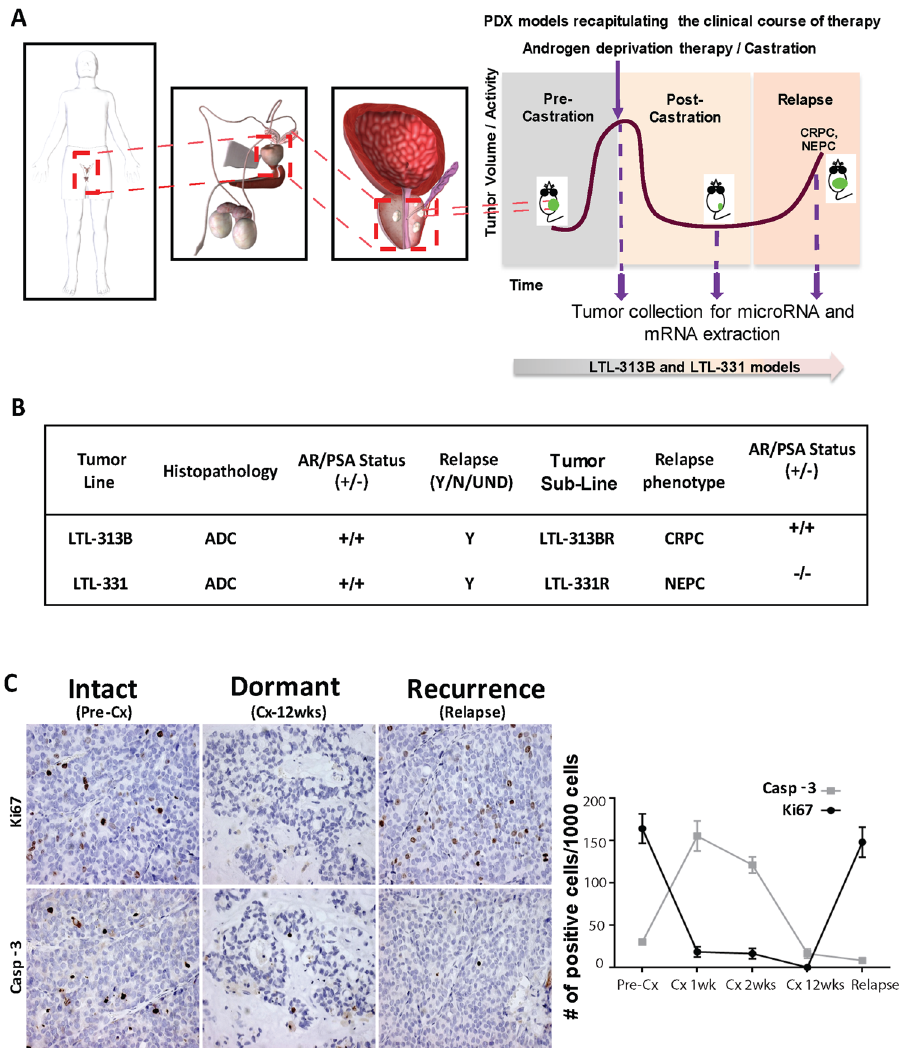
Figure 1. PDX models recapitulating PCa disease progression. PDX models recapitulating clinical course of therapy: ( A ) Two hormone-sensitive prostate PDX models were generated and subjected to surgical castration (androgen deprivation). Upon the emergence of a castration-resistant sub-line, pathological examination stratified the tumors into either adenocarcinoma (CRPC) or neuroendocrine (NEPC) phenotypes. Drawings are adapted from BioDigital Human Application (human.biodigital.com) who hold the copyright and permit this publication under an Open Access license. ( B ) Characterization of the fate of PDX models (abbreviations: LTL = living tumor laboratory, ADC = adenocarcinoma, Y = yes, N = no, UND = undetermined, CRPC = castration-resistant prostate cancer, NEPC = neuroendocrine prostate cancer). Evidence of therapy induced dormancy and resistance. ( C ) Surgical castration can induce tumor dormancy in vivo using PCa PDX models: ( A ) Immunohistochemical staining of tissues obtained from LTL-313B PDX model. Cell proliferation and apoptosis are detected with Ki67 and Caspase-3 antibodies measuring protein expression, respectively. ( D ) Quantification of proliferation and apoptosis in LTL-313B tumors through determining the number of positively stained cells/1000 cells in the pre-castration, dormancy and relapse